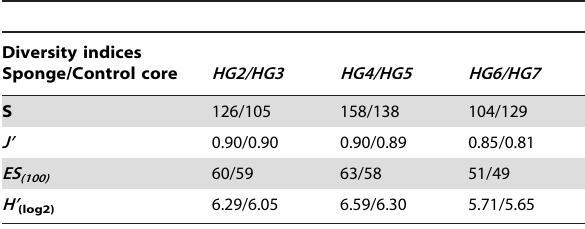
Diversity indices Sponge/Control core